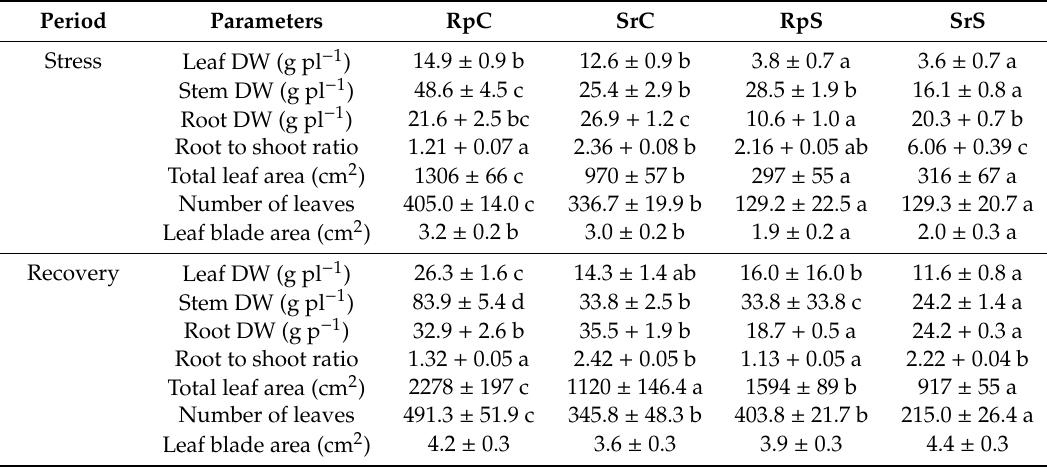
Table 1. Growth parameters at the end of the stress and recovery period in P. dulcis subjected to di ff erent irrigation treatments: plants grafted under full irrigation (RpC), self-rooted plants under full irrigation (SrC), plants grafted submitted to water stress (RpS) and self-rooted plants submitted to water stress (SrS.). Means within a row without a common letter are significantly di ff erent by the Duncan 0.05 test. Each value is the mean of eight plants per